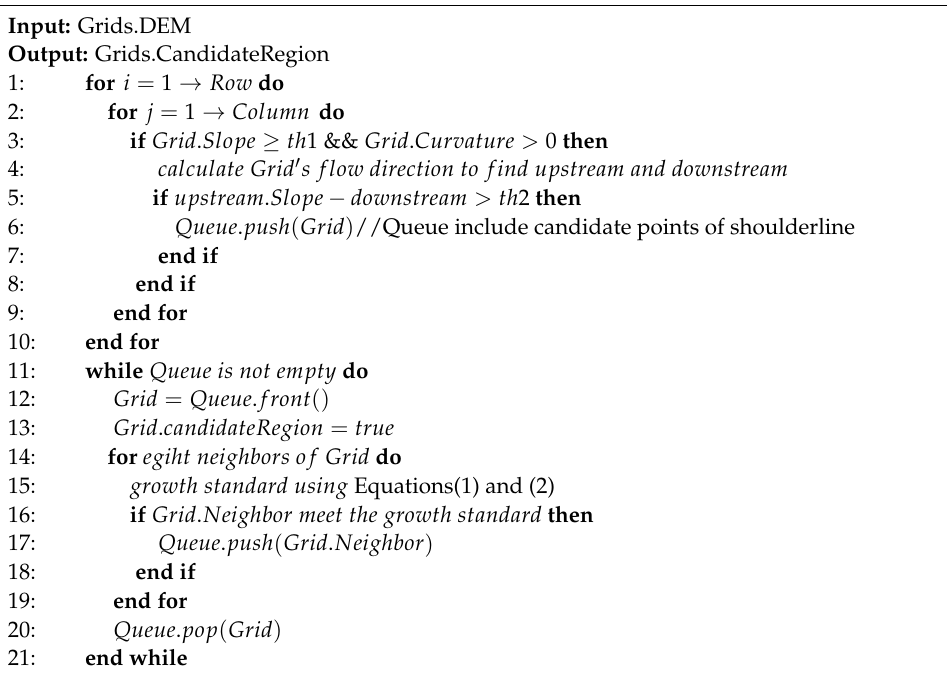
Algorithm 1 Iterative calculation of Shoulder-line candidate region